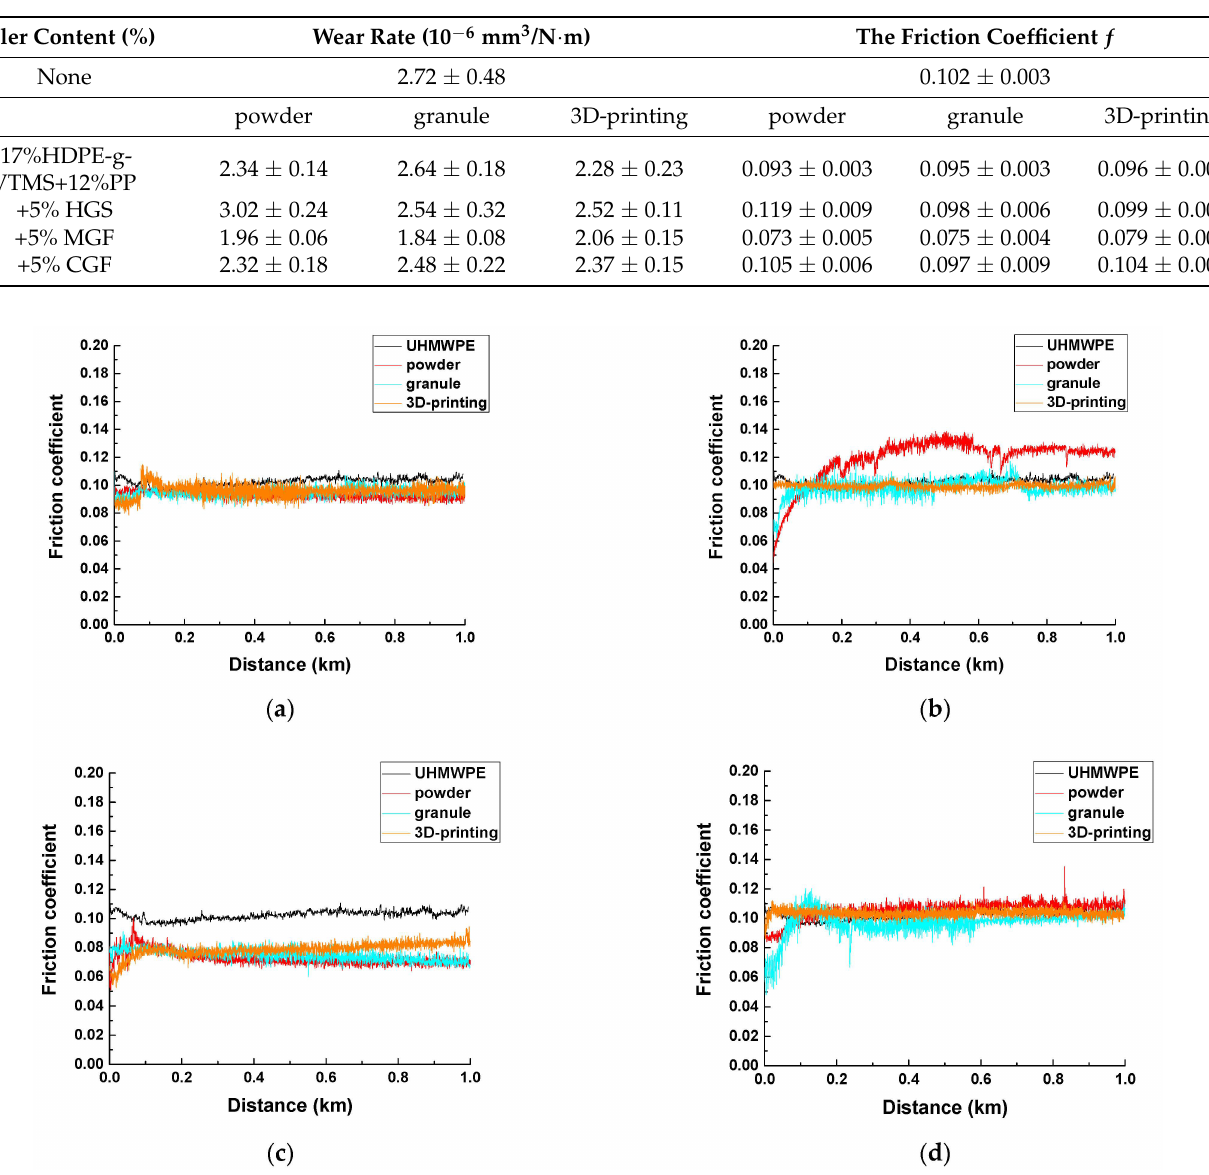
Table 6. The tribological characteristics of neat UHMWPE and the ‘UHMWPE+17%HDPE-g-VTMS+12%PP’-based compos- ites. The ‘pin-on-disk’ scheme.